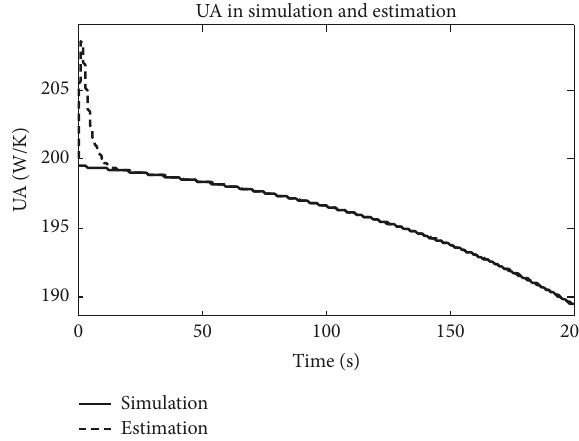
Figure 5: Overall heat transfer coefficient (UA) simulation by math model and estimation by